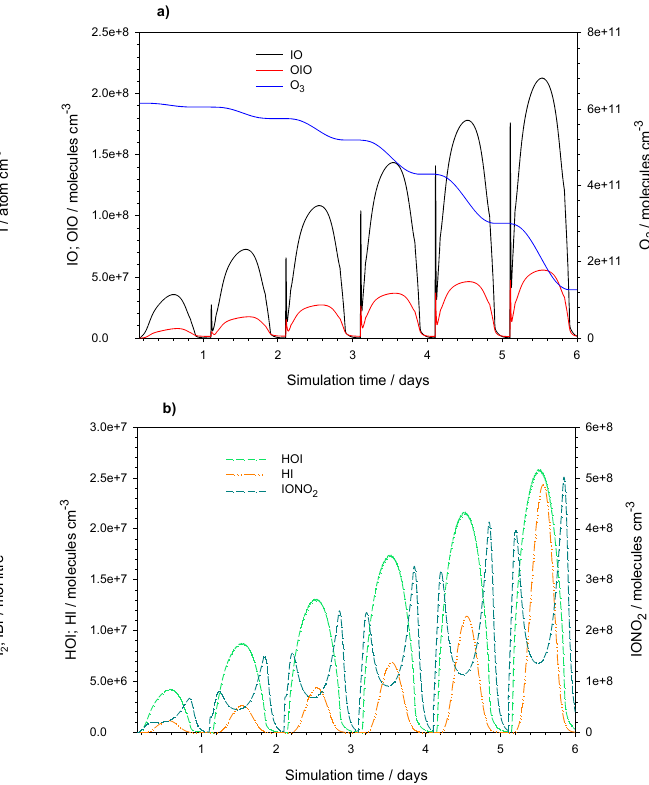
Figure 4. Modelled concentrations of gas-phase iodine species re- sulting from the emission of I 2 from sea ice over 6 days from the start of the simulation. Following the build-up of I 2 during the pre- ceding night, the model predicts a post-sunrise pulse of IO fol- lowed by a diurnal cycle shaped by solar radiation. The HOI (from IO + HO 2 ) and HI (from I + HO 2 ) profiles track the diurnal cycle of HO 2 and solar radiation. By contrast, IONO 2 will photolyse very efficiently during the day, yielding its typical diurnal cycle with maxima in mid-morning and late